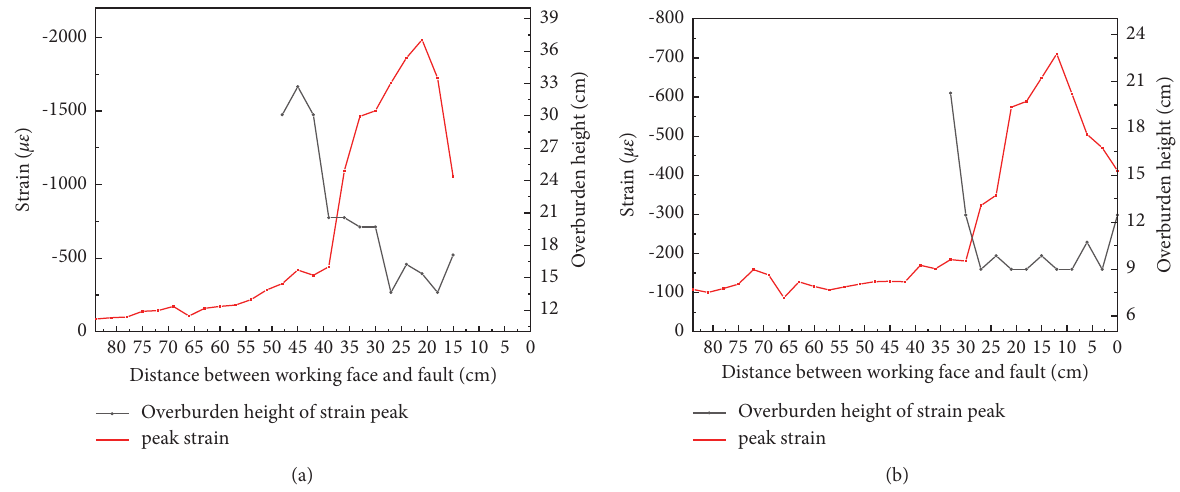
Figure 10: Variation of peak shear strain at the fault surface at different distances between the working surface and the fault. (a) Physical model I. (b) Physical model II.